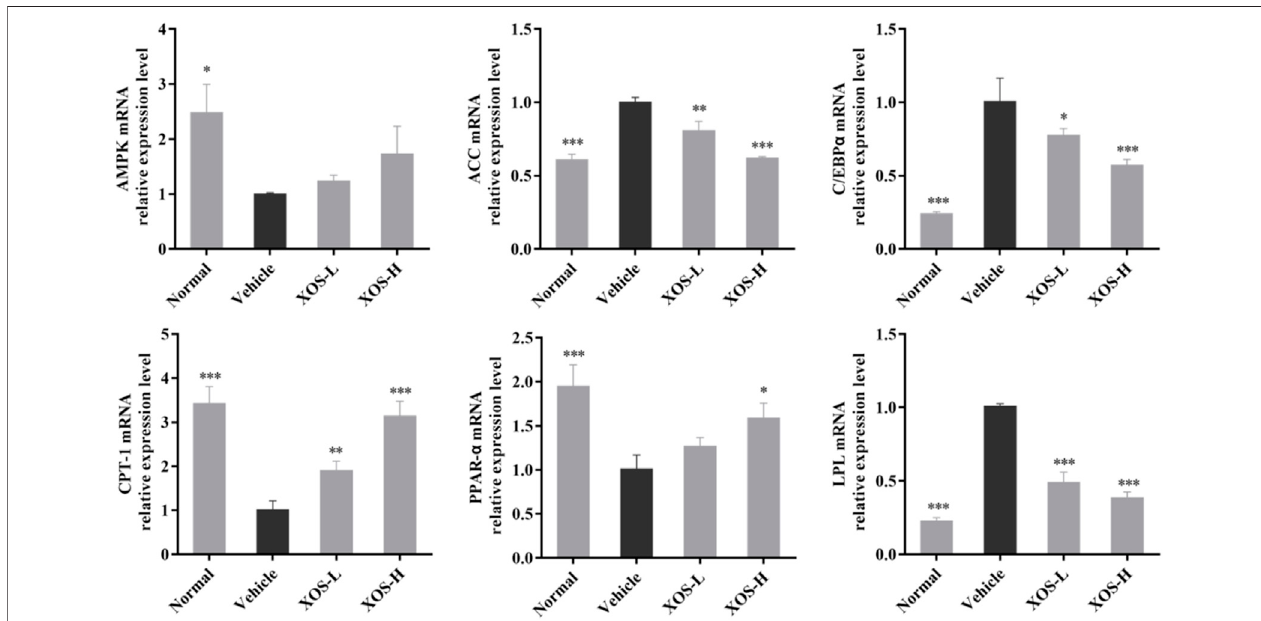
FIGURE 6 | Effect of XOS supplementation on AMPK, ACC, C/EBP α , CPT-1, PPAR- α , and LPL mRNA expression in epididymal fat tissue of mice. XOS-L: mice treat with XOS 250 mg/kg, XOS-H: mice treat with XOS 500 mg/kg. * p < 0.05, ** p < 0.01, *** p < 0.001 compared with the Vehicle group.